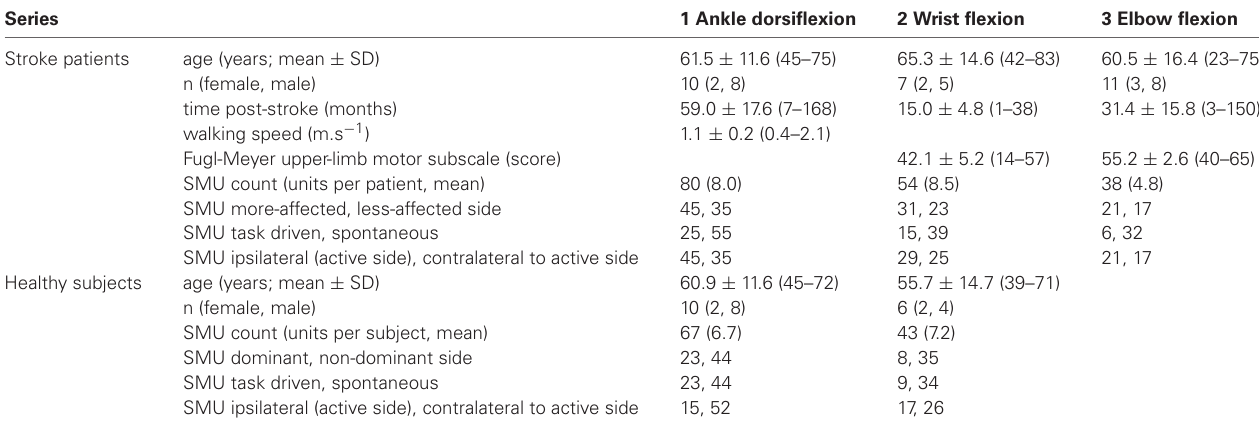
Table 1 | Participant demographics and summary of single motor unit recordings